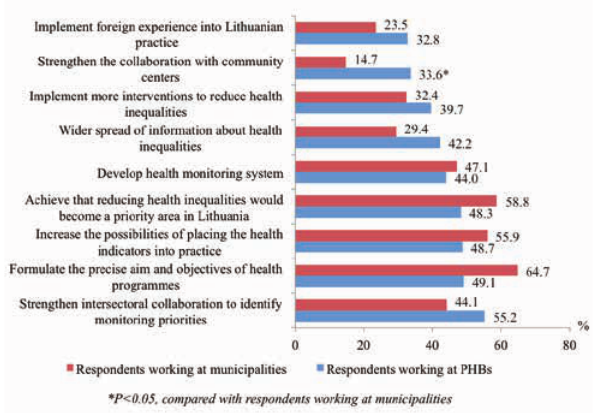
Figure 4: Activities recommended by respondents working at muni- cipalities and PHBs for better health inequality